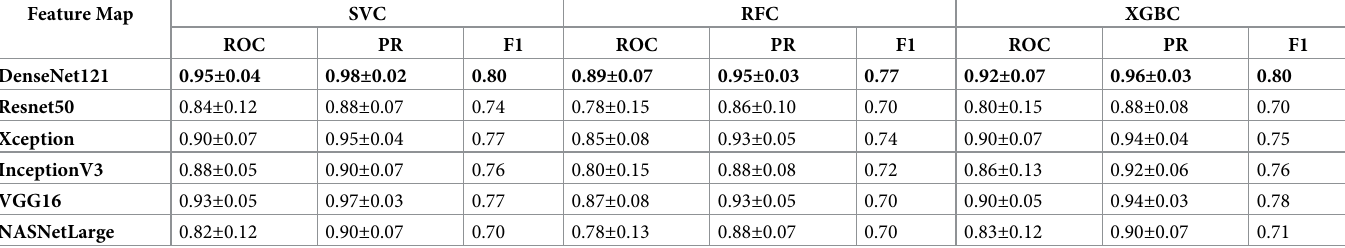
ROC (Area under the ROC curve), PR (Area under the precision-recall curve), F1 (F1 Score), SVC (Support Vector classifier), RF (Random Forest classifier), XGBC (XGBoost classifier). Bold-faced values indicate the best performance for each model.